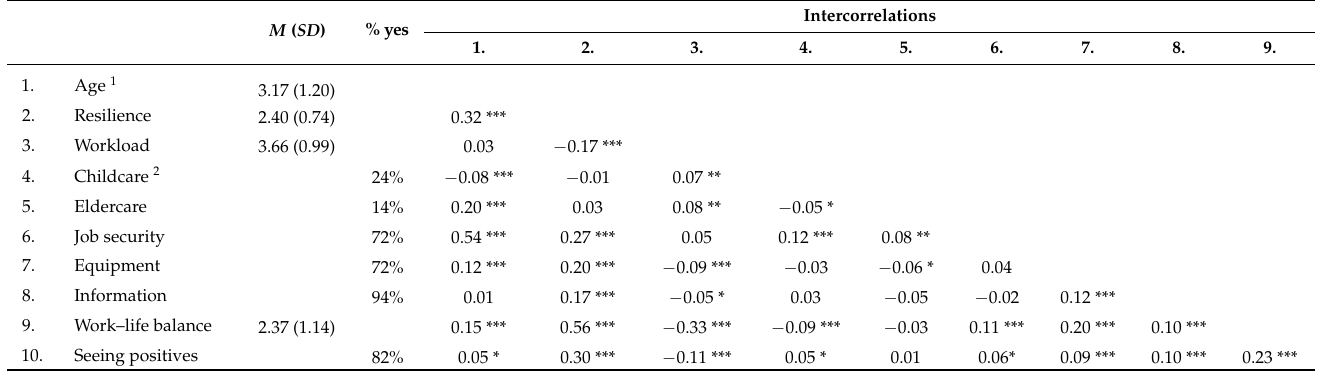
Table 2. Descriptions and intercorrelations of central